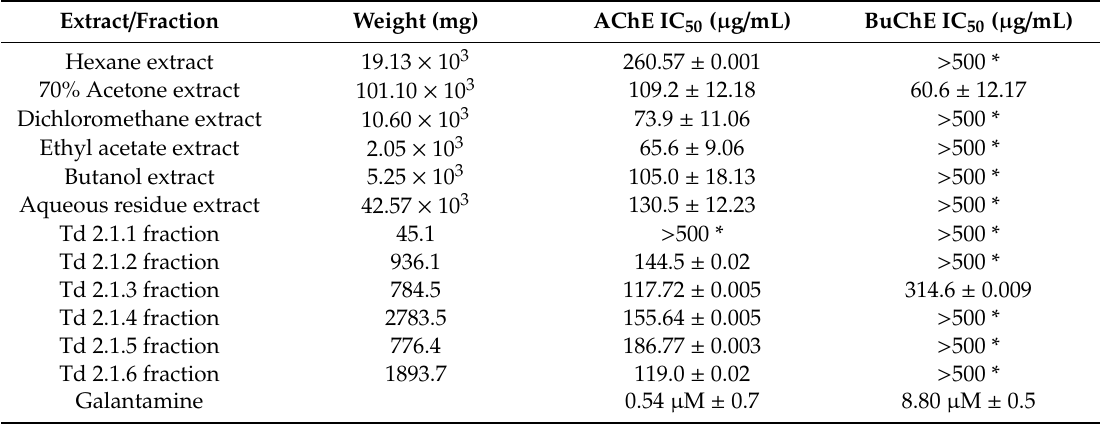
Table 2. Cholinesterase (acetylcholinesterase (AChE) and butyrylcholinesterase (BuChE))-inhibiting activities of Tithonia diversifolia extracts and fractions. Extract / Fraction Weight (mg) AChE IC 50 ( µ g / mL) BuChE IC 50 ( µ g /